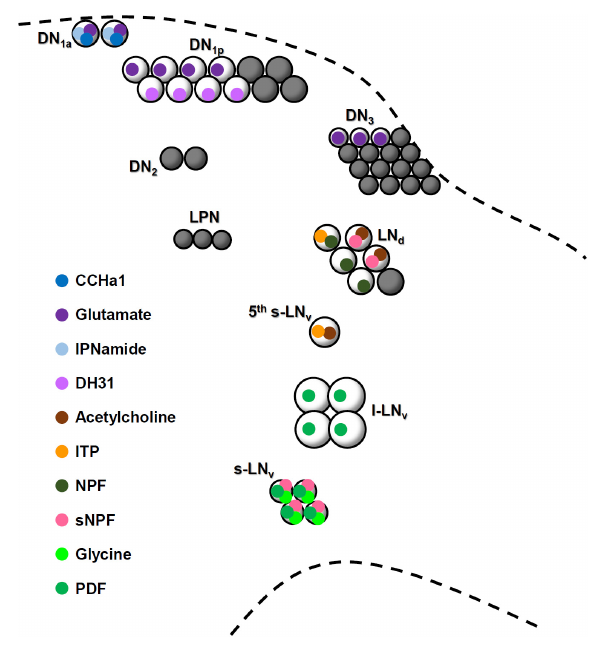
FIGURE 8 | PDF-immunoreactivity of CCHa1 mutants in the s-LN v terminals. (A) Representative images of PDF immunostaining in the s-LN v dorsal protocerebrum terminals. The samples were collected at ZT2 and ZT11. The upper panels indicate results of PDF staining from the w 1118 control strain and the lower panels indicate the same from CCHa1 SK8 mutants. (B) The PDF staining intensity was measured at the s-LN v terminals. (C) Data show mean intensity ( ± SEM) calculated from results pooled from three independent experiments. Numbers in the columns indicate the number of brain hemispheres used. One-way ANOVA with Tukey’s multiple comparison test after the Kolmogorov–Smirnov test; ∗ p < 0.05, ∗∗ p < 0.01.